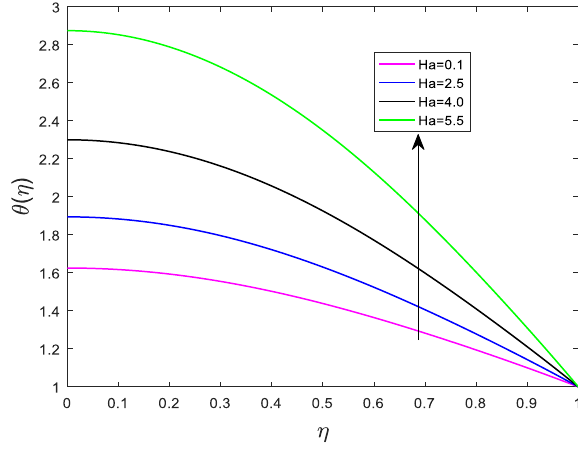
Figure 12: Effect of Ha on θ ( η ) for fixed S = 0.6, β = 5.0, N t = Kr = 0.1, Ω T = 0.5, Ω C = 1.5, Ec = 0.1, N b = 2.0, Pr = 0.7 and Sc = 0.7